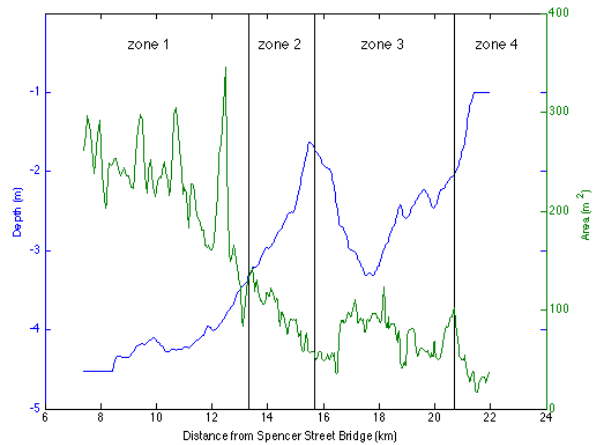
Fig. 2. Depth and cross sectional area of Yarra River estuary as a function of distance from Port Philip Bay. Vertical black lines rep- resent the 3 points of inflection described in the